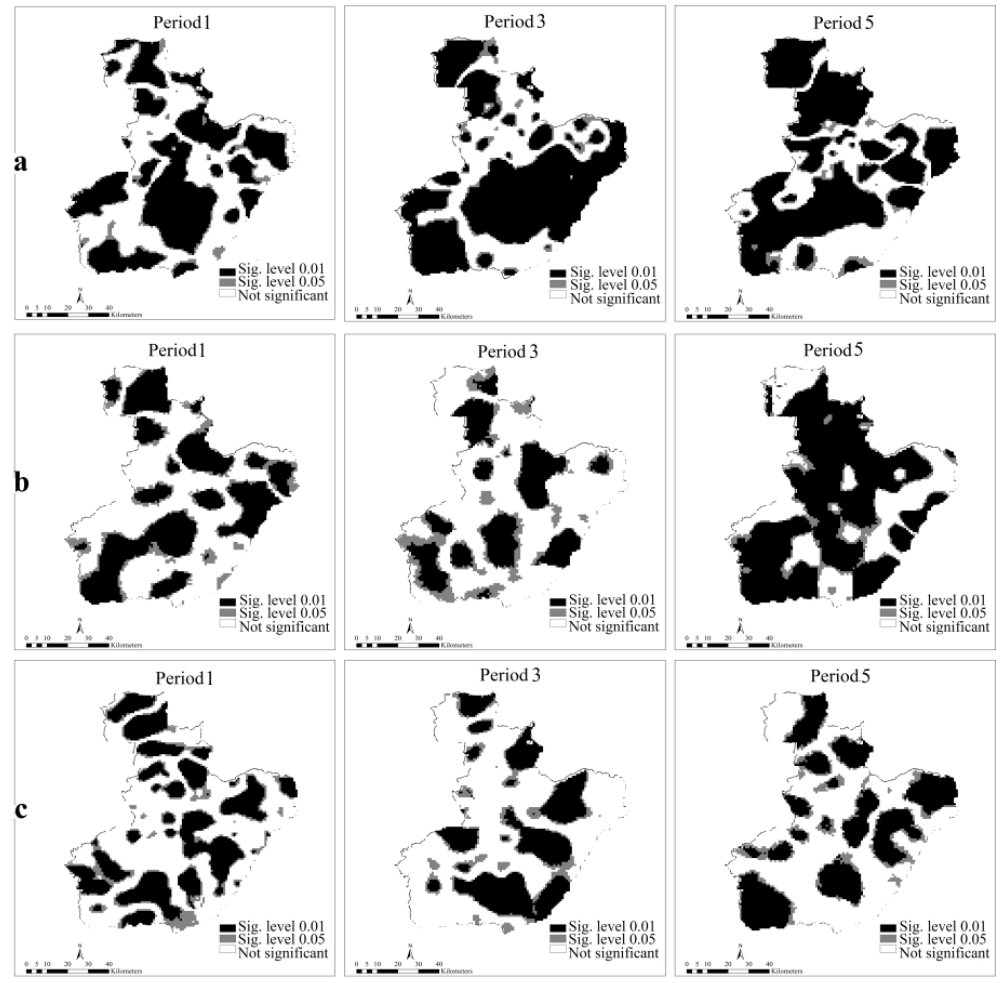
Figure 10. t -test values of the coefficients for GTWR in different periods at the resolution of 100 m. The letters ( a – c ) represent ENTERPRISE, LINE, and DEM respectively. The darker of the color, the more significant the coefficient is. White means the variable is not significant within that region, black indicates the variable is at the significance level of 0.01, and dark gray indicates a significance level of 0.05 ( t -test value is 2.58 and 1.96 respectively).